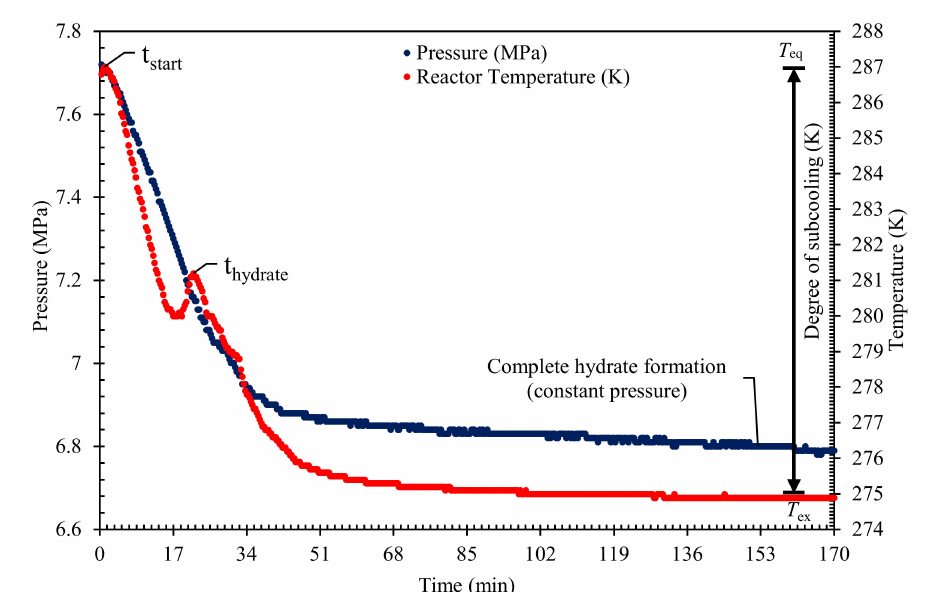
Figure 6. A typical Time versus pressure and temperature plot to indicate the induction time and gas uptake during hydrate formation in a constant cooling